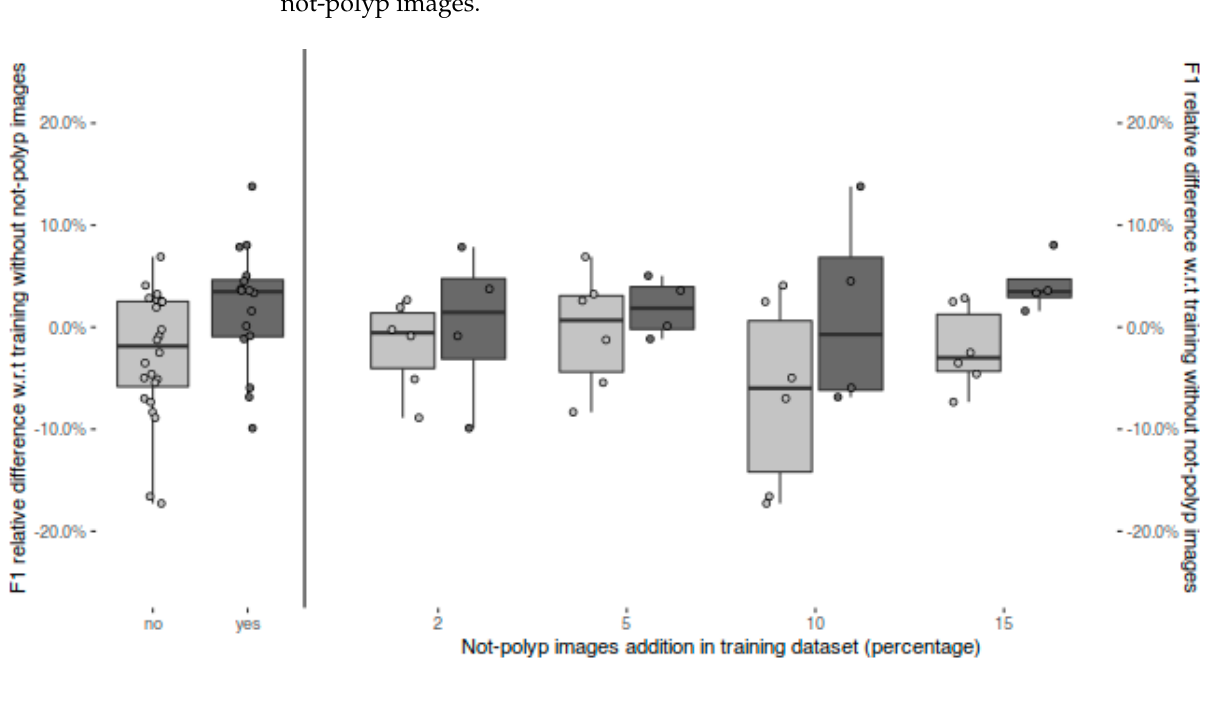
Figure 6. Relative F1 differences in the same test dataset with respect to our baseline model (trained without not-polyp images), and grouped test dataset type (i.e., containing or not containing not- polyp images).